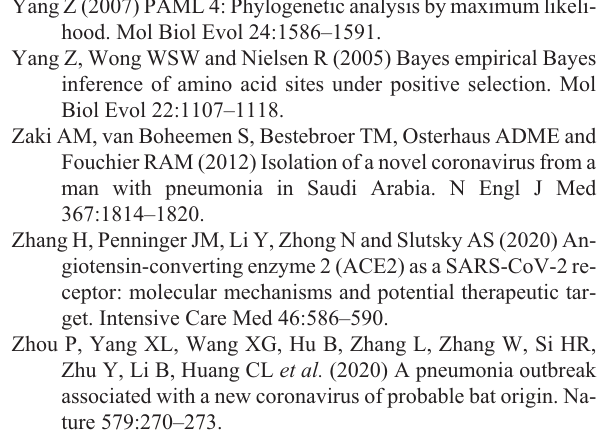
Table S1 - Placental mammal species analyzed. Table S2 - Evolutionary rates estimated considering 70 ACE2 placental mammal orthologues. Table S3 - Bayesian Empirical Bayes (BEB) analysis indi- cating sites with high probability (> 95%) to be under posi- tive selection Table S4 - Bayes Empirical Bayes (BEB). General results. Signal peptide (1-17),extracellular domain (residues